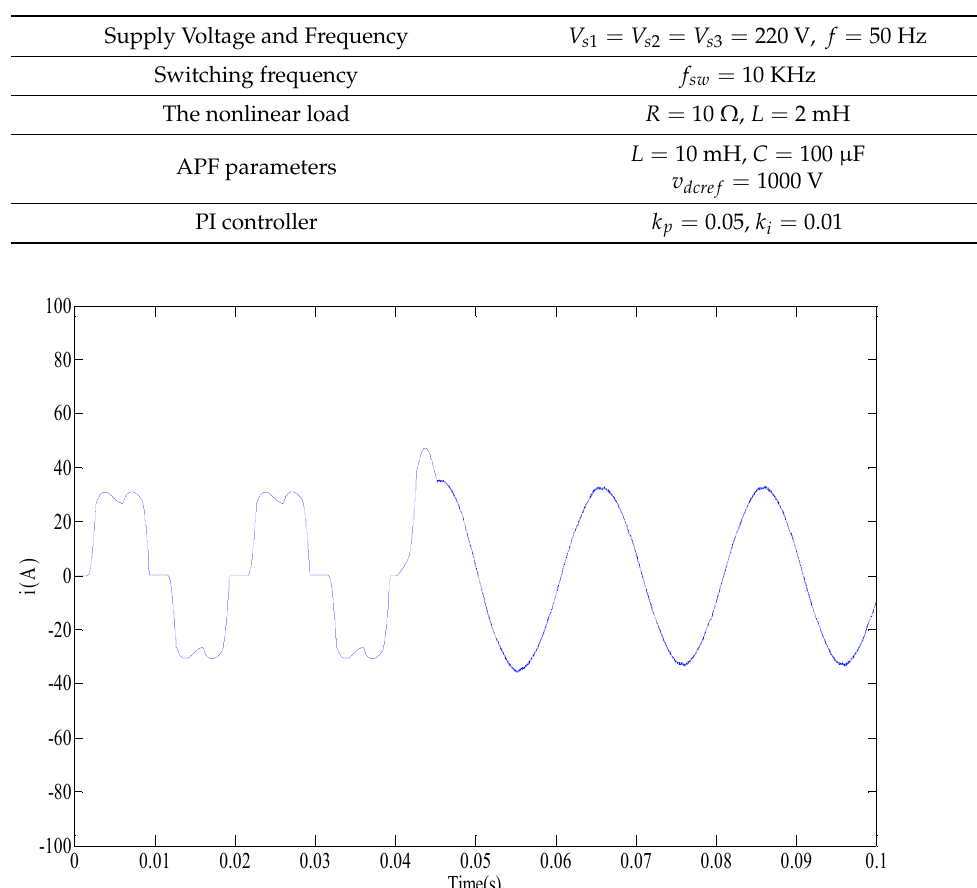
Figure 4. Improved source current of the A phase.